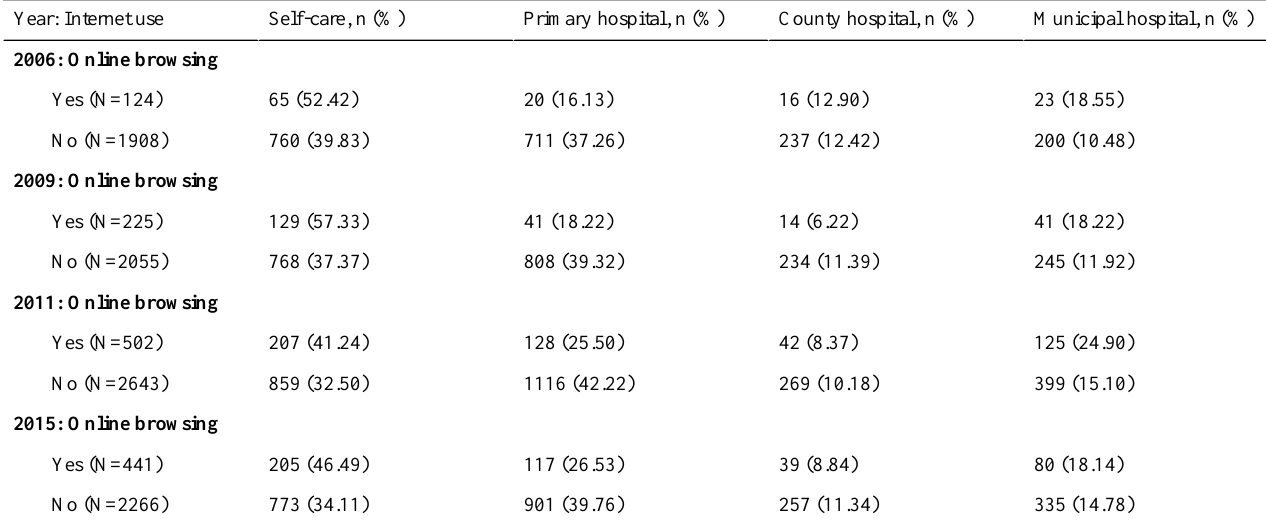
Table 4. Association between internet use and medical decisions in different survey